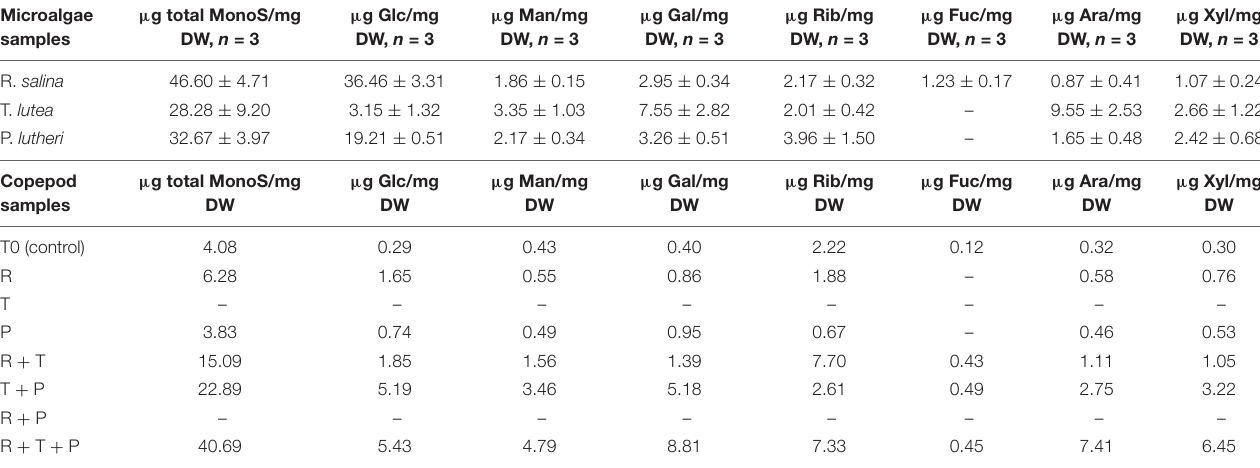
TABLE 2 | Total monosaccharide amounts and respective amounts of seven specific monosaccharides for each copepod and microalgae lyophilized sample. Microalgae